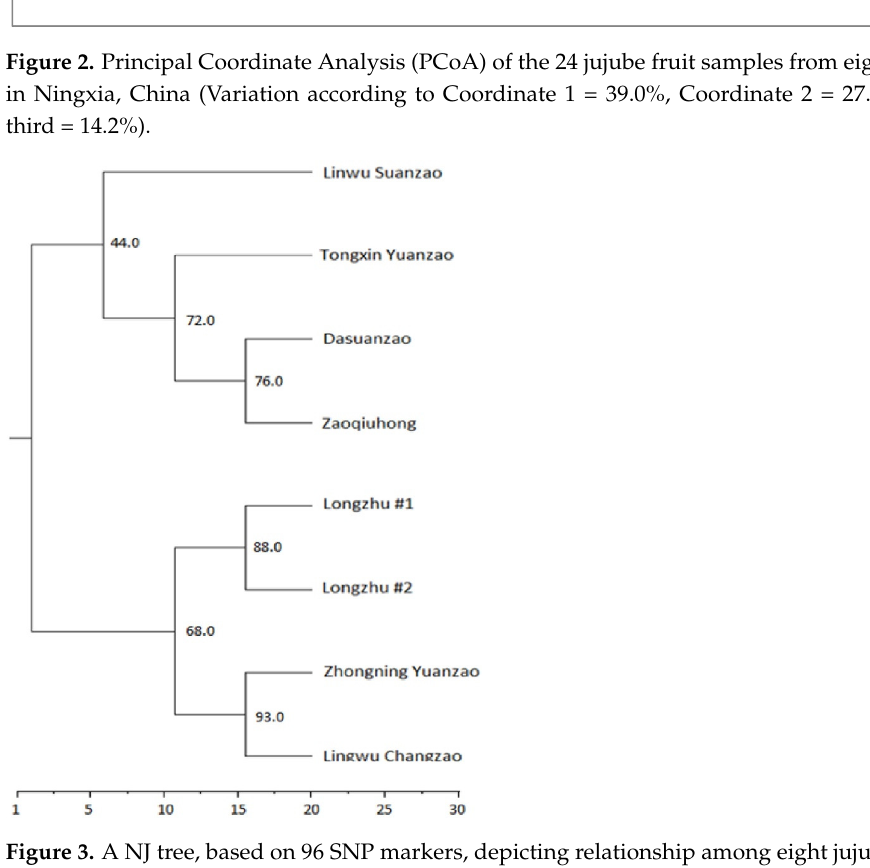
Figure 3. A NJ tree, based on 96 SNP markers, depicting relationship among eight jujube cultivars from Ningxia, China. Table 5. Expected number of individuals with the same multilocus genotype for increasing locus combinations (number of loci = 24). PI = Probability of Identity; PID-sib = Sibling probabilities of identity; PIC= polymorphism information content.